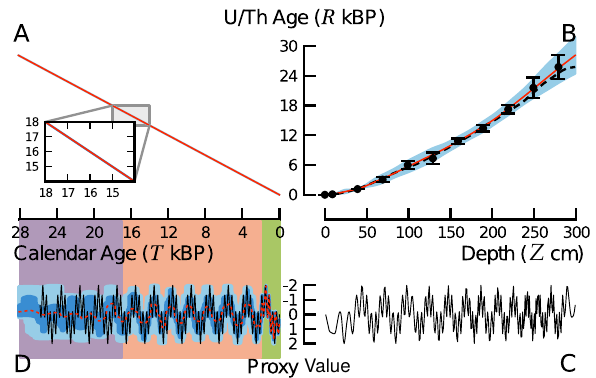
Figure 4. U / Th-dated synthetic stalagmite. Legend as in Fig. 2. Fig. 4. U/Th dated synthetic stalagmite. Legend as in Fig.2. A. The (a) The straight line of slope 1 used in place of a calibration curve. straight line of slope one used in place of a calibration curve. In- Inset: unlike a real calibration curve, this line has no error. (b) U / Th set : Unlike a real calibration curve, this line has no error. B. U/Th measurements from a synthetic stalagmite (circles with error bars) measurements from a synthetic stalagmite (circles with error bars) and the estimated radiometric age model obtained from them by re- and the estimated radiometric age model obtained from them by re- gression (red line with blue ≈ 95% confidence band), along with the gression (red line with blue 95% confidence band), along with actual age model (black dashes). (c) The proxy curve along stalag- ≈ actual age model (black dashes). C. The proxy curve along stalag- mite depth obtained from noise-free proxy measurements. (d) The mite depth obtained from noise-free proxy measurements. D. The actual proxy record (black), shown alongside the estimated median actual proxy record (black), shown alongside the estimated median proxy record (red, dotted), along with the associated uncertainty of proxy record (red, dotted) along with associated uncertainty of es- estimation (sky blue denotes the interquartile range, i.e., 50% confi- timation (sky blue denotes the interquartile range, i.e., 50% confi- dence, whereas light blue denotes the region between the 97.5th and dence, whereas light blue denotes the region between the 97.5 th and 2.5th percentiles, i.e., 95% confidence). The estimated record in D the 2.5 th percentiles, i.e., 95% confidence). The estimated record in is demarcated into three distinct regions in terms of the frequen- D is demarcated into three distinct regions in terms of the frequen- cies it resolves: (a) when it resolves both frequencies of the true cies it resolves: (a) when it resolves both frequencies of the true sinusoidal proxy record (green), (b) when it resolves only the lower sinusoidal proxy record (green), (b) when it resolves only the lower frequency (orange), and (c) when it is unable to resolve either of the frequency (orange), and (c) when it is unable to resolve either of the two frequencies (purple). (Color two frequencies (purple). (Color online.)